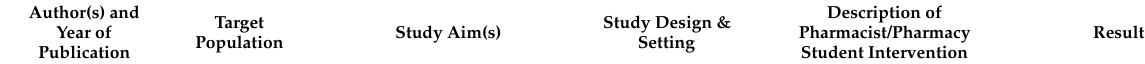
Table 5. Primary prevention